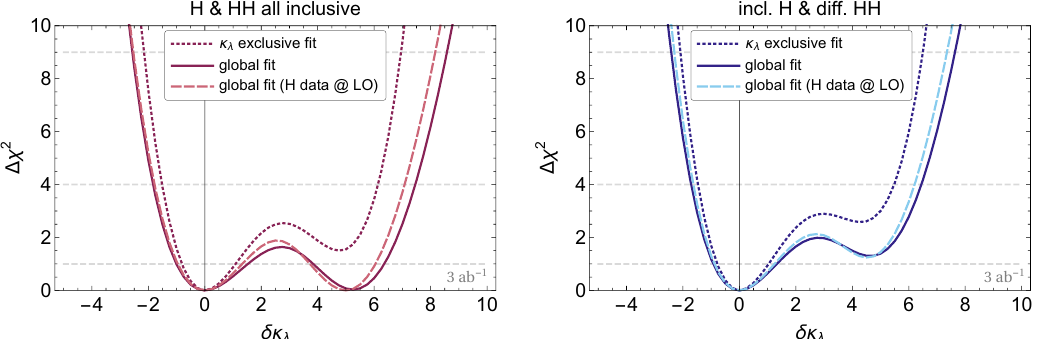
Figure 4 . Left: the solid curve shows the global (cid:31) 2 as a function of the corrections to the Higgs trilinear self-coupling obtained from a (cid:12)t exploiting inclusive single Higgs and inclusive double Higgs observables. The dashed line shows the (cid:12)t obtained by neglecting the dependence on (cid:14)(cid:20) (cid:21) in single- Higgs observables. The dotted line is obtained by exclusive (cid:12)t in which all the EFT parameters, except for (cid:14)(cid:20) (cid:21) , are set to zero. Right: the same but using di(cid:11)erential observables for double